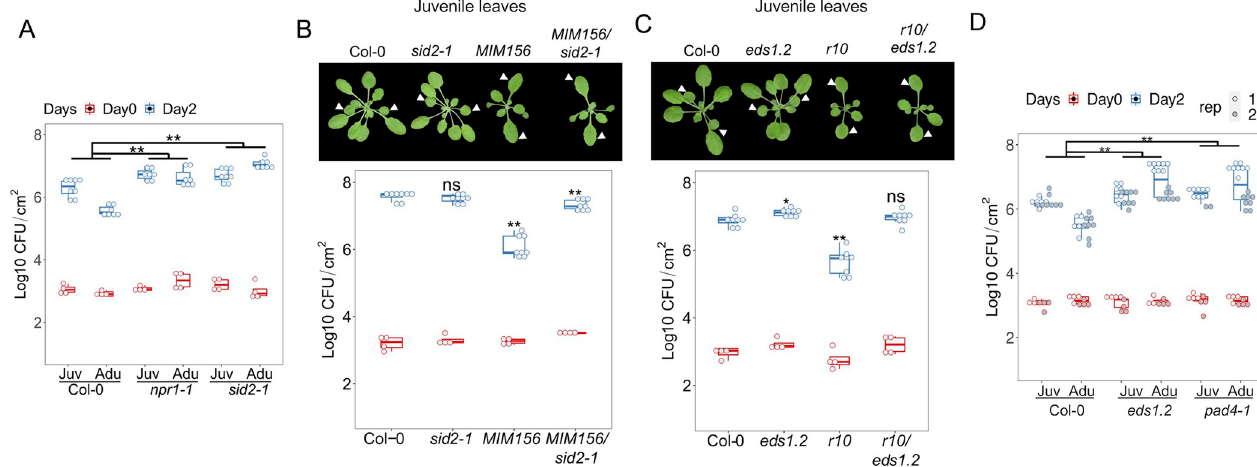
Fig 7. SA biosynthesis and signaling components were required for the SPL10 regulated ARR VPC . A , a comparison of Pto DC3000 growth between the juvenile and adult leaves (ARR phenotype) of Col-0, sid2-1 and npr1-1 . B , developmental phenotype (top) and the bacterial growth (bottom) in 4-week-old leaves 1 and 2 from Col-0, sid2-1 , MIM156 and MIM156/sid2-1 . C , developmental phenotype of 4-week-old Col-0, eds1 . 2 , r10 and r10 /eds1 . 2 . Note the similar leaf shape between r10 and r10 / eds1 . 2; (bottom panel) bacterial multiplication in leaves 1 and 2 derived from Col-0, eds1 . 2 , r10 and rSPL10/eds1 . 2 . Arrows indicate leaves 1–2. D , the ARR phenotyping of eds1 . 2 and pad4-1 infected with Pto DC3000. Emmeans package in R was used for statistical analysis in 7 A and D. The student t test was used for statistical analysis in 7 B-C, and each genotype was compared with Col-0 wild type, ns, not significant, � , p < 0.05, �� , p <